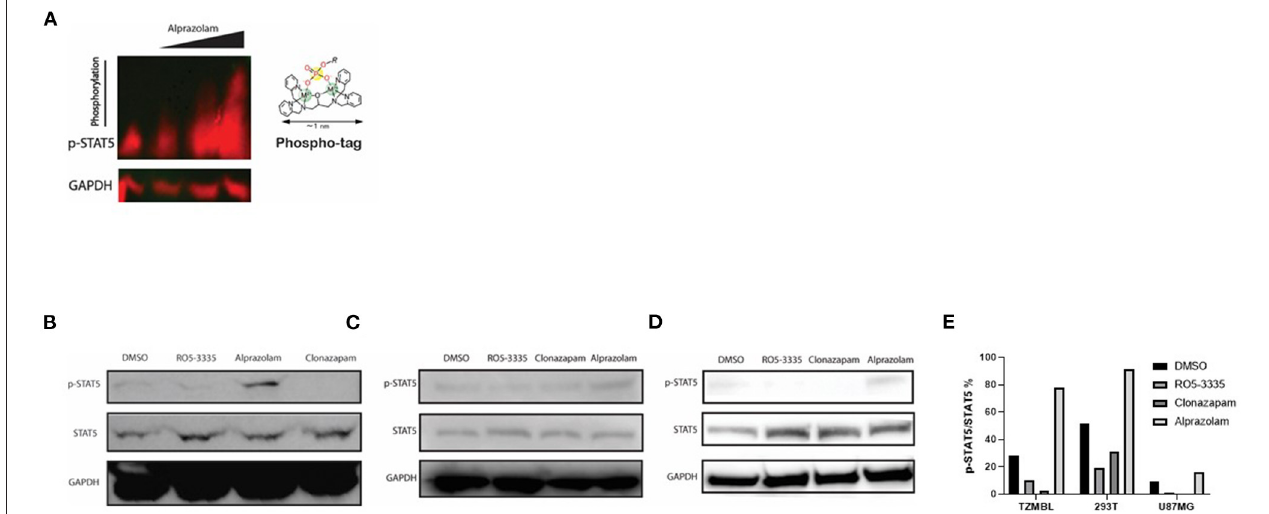
FIGURE 7 | Expression of Activated STAT5 was increased when TZMBL cells were treated with Alprazolam. TZMBl (A, B) , HEK293T (C) and U87MG (D) cells were treated with Benzodiazepines: 50 µ M RO5-3335, 10 µ M Alprazolam, or 10 µ M Clonazepam for 48h. Cells were lysed and whole cell lysate was collected and loaded onto an SDS-PAGE Gel (A) Phospho-Tag SDS-PAGE was performed to evaluate the dose effect of alprazolam on STAT5 phosphorylation. From left to right, TZMBL cells were treated with DMSO, 0.1 µ M, 1 µ M and 10 µ M of Alprazolam. (B–D) Western Blot was performed to evaluate the effect of Benzodiazepines on STAT5 expression and phosphorylation (E) Densitometry was performed and the ratio of activated STAT5 over global STAT5 was graphed.